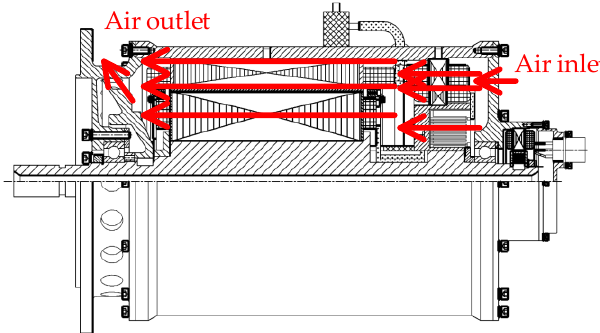
Figure 9. Schematic diagram of generator cooling air path